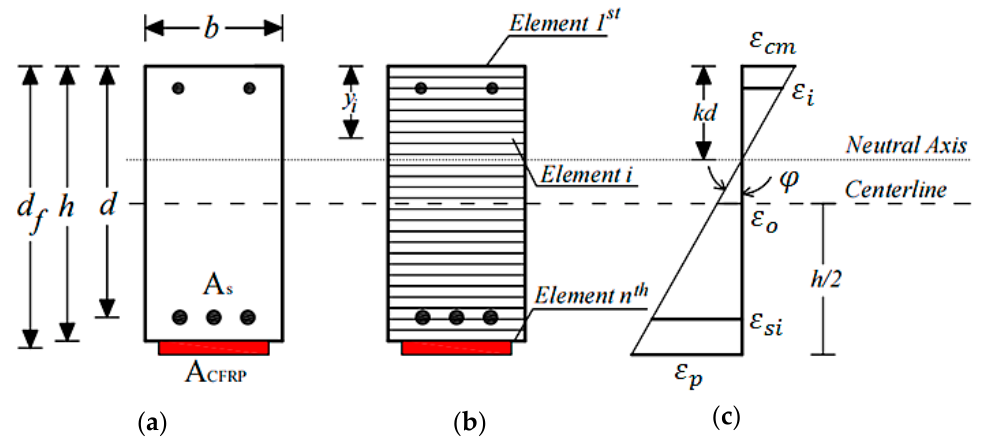
Figure 4. Analytical model using the fiber element method ( a ) reinforced concrete cross section, ( b ) fiber element model, and ( c ) strain distribution.